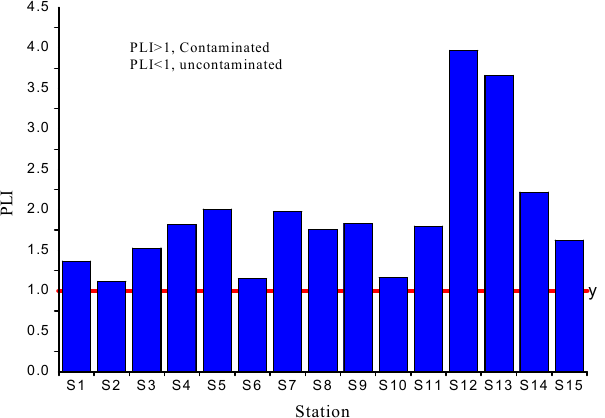
Figure 6. Pollution load index of surface sediment in the Perak River. Straight line at point 1 represents the reference line for pollution indication [42].